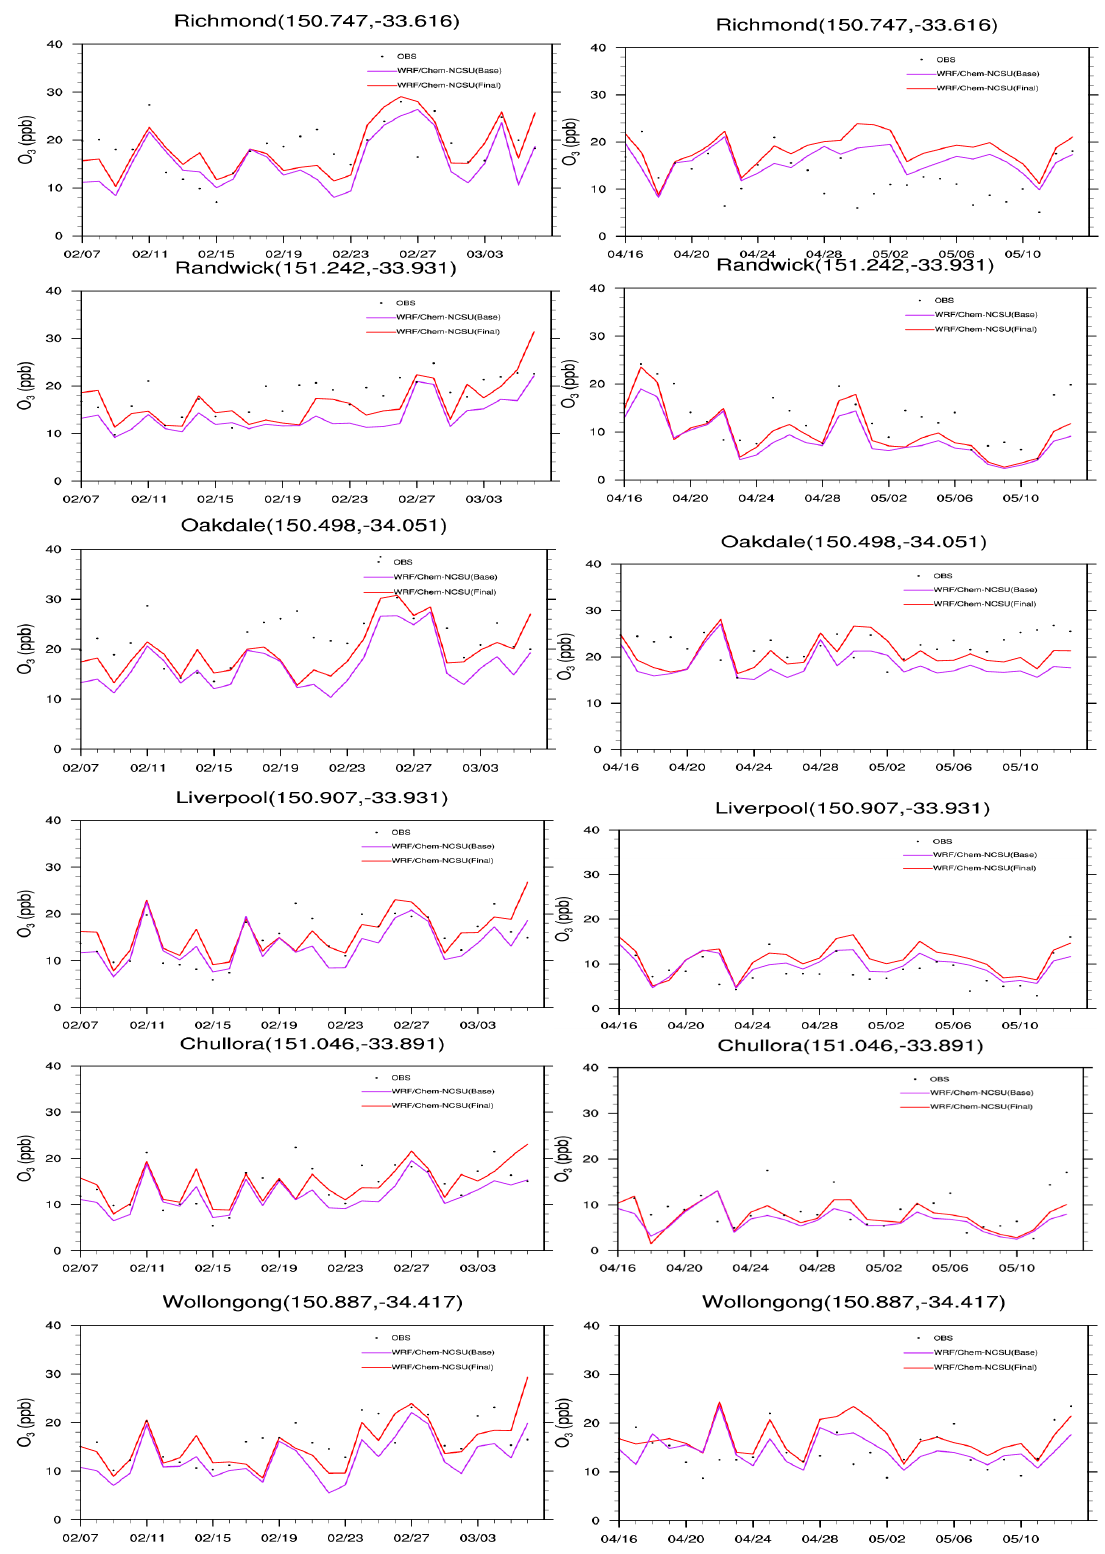
Figure 13. Observed and simulated surface concentrations of O 3 at selected sites during SPS1 (left) and SPS2 (right). Two sets of simulation results from WRF / Chem-NCSU at 3 km are compared, one using O 3 boundary conditions derived from CESM simulations (Base) and one using O 3 boundary conditions constrained by satellite data (Final).